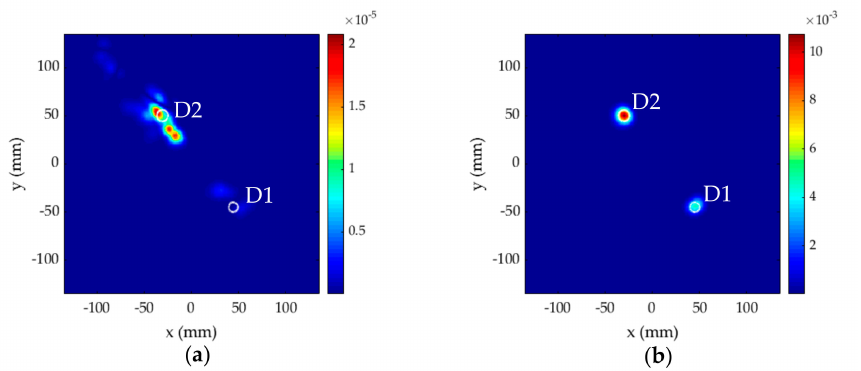
Figure 19. Aggregate damage image for the multiple damage scenario in pulse–echo configuration: ( a ) without time compensation; ( b ) with time